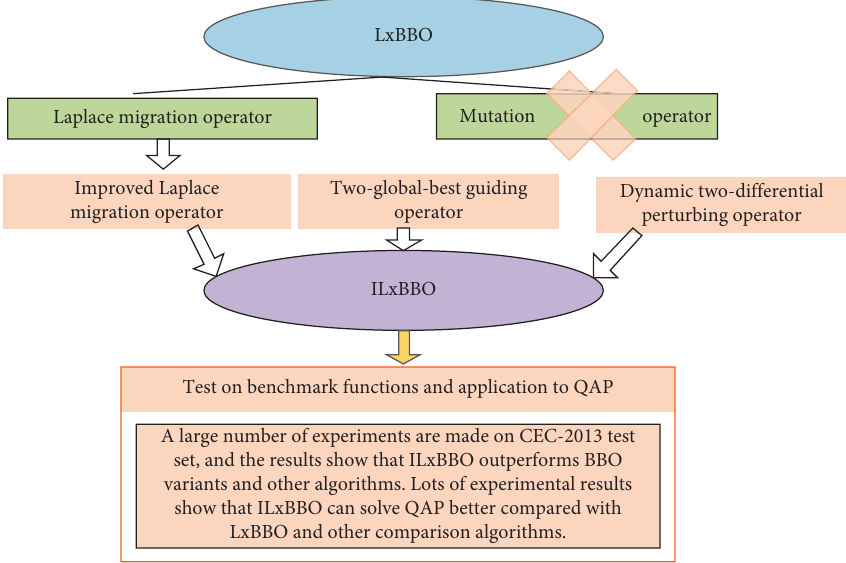
Figure 1: Graphical abstract of this